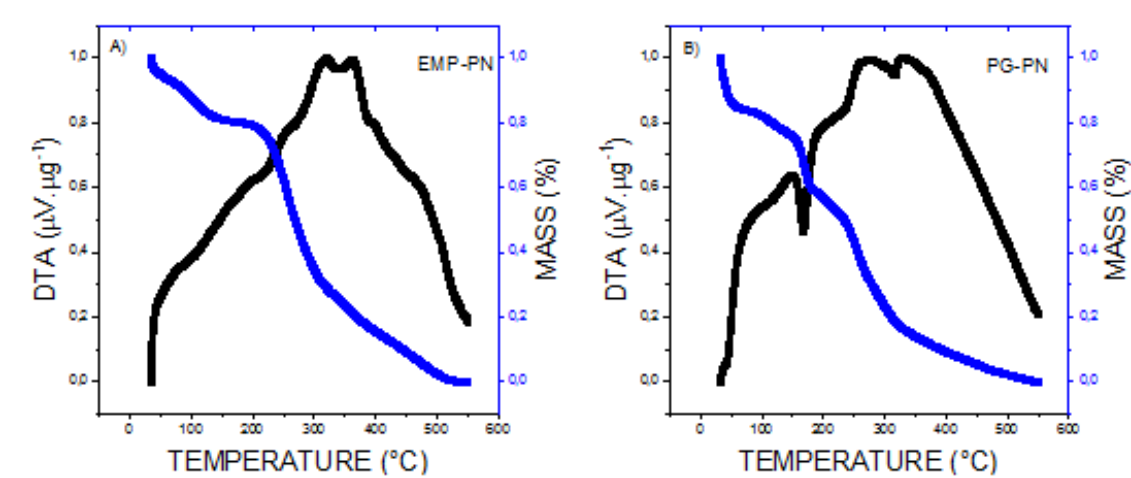
Figure 9. TG (in blue line) and DTA (in black line) curves of EMP-PN ( A ) and PG-PN ( B ) obtained due to heating at 10 °C/min in the range from 25 to 550 °C, under dynamic nitrogen atmosphere